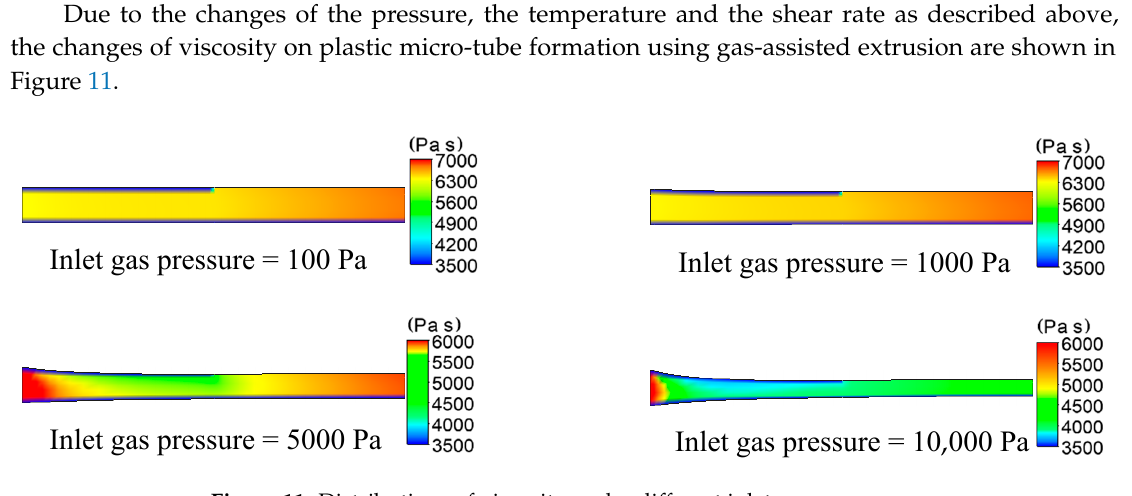
Figure 11. Distributions of viscosity under different inlet gas pressures.